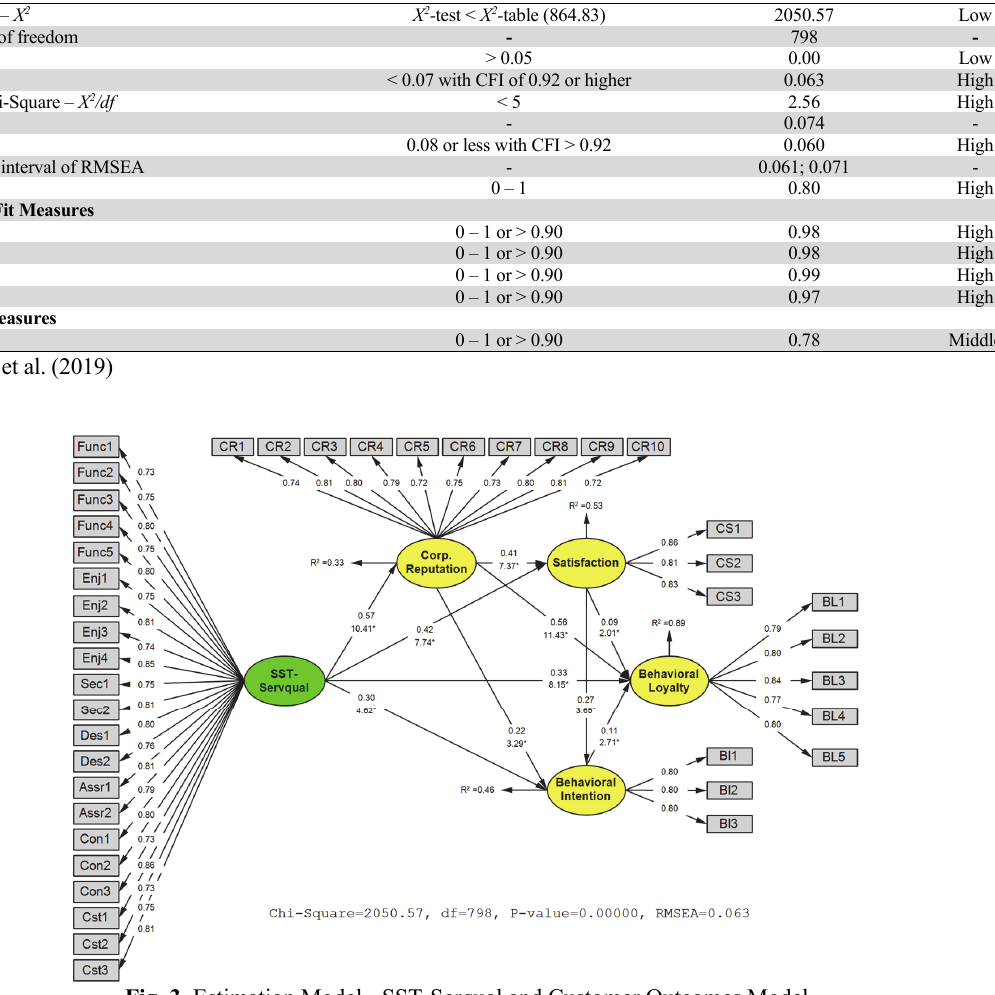
Fig. 3 . Estimation Model - SST-Serqual and Customer Outcomes